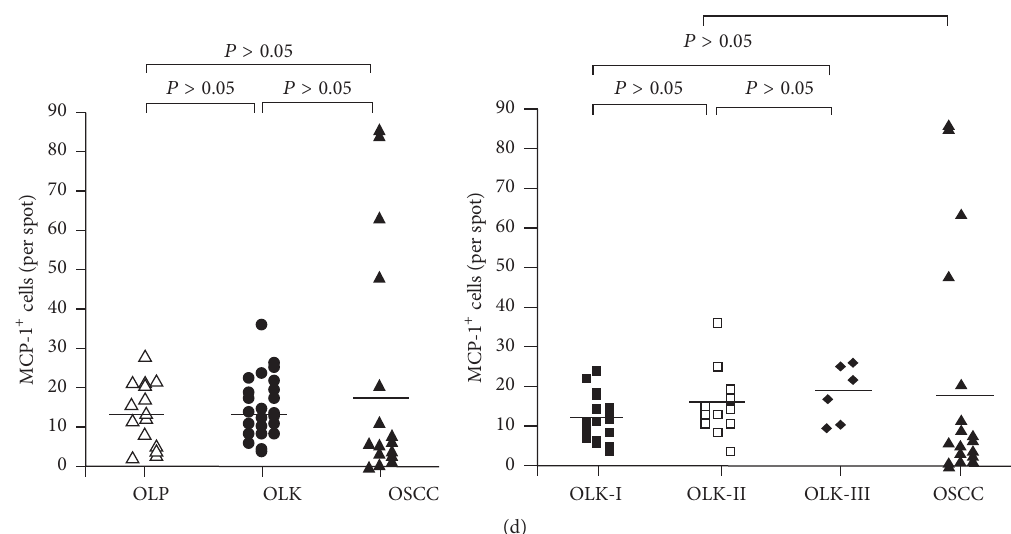
Figure 4: Distribution and frequency of IFN- 𝛾 and MCP-1 positive macrophages in OLP, OLK, and OSCC tissues. (a) IFN- 𝛾 -immunostained sections of OLP, OLK, and OSCC tissue. (b) Frequency of IFN- 𝛾 + macrophages in OLP, OLK-I, OLK-II, OLK-III, and OSCC tissue. (c) MCP- 1-immunostained sections. (d) Frequency of MCP-1 + macrophages in OLP, OLK-I, OLK-II, OLK-III, and OSCC tissue.